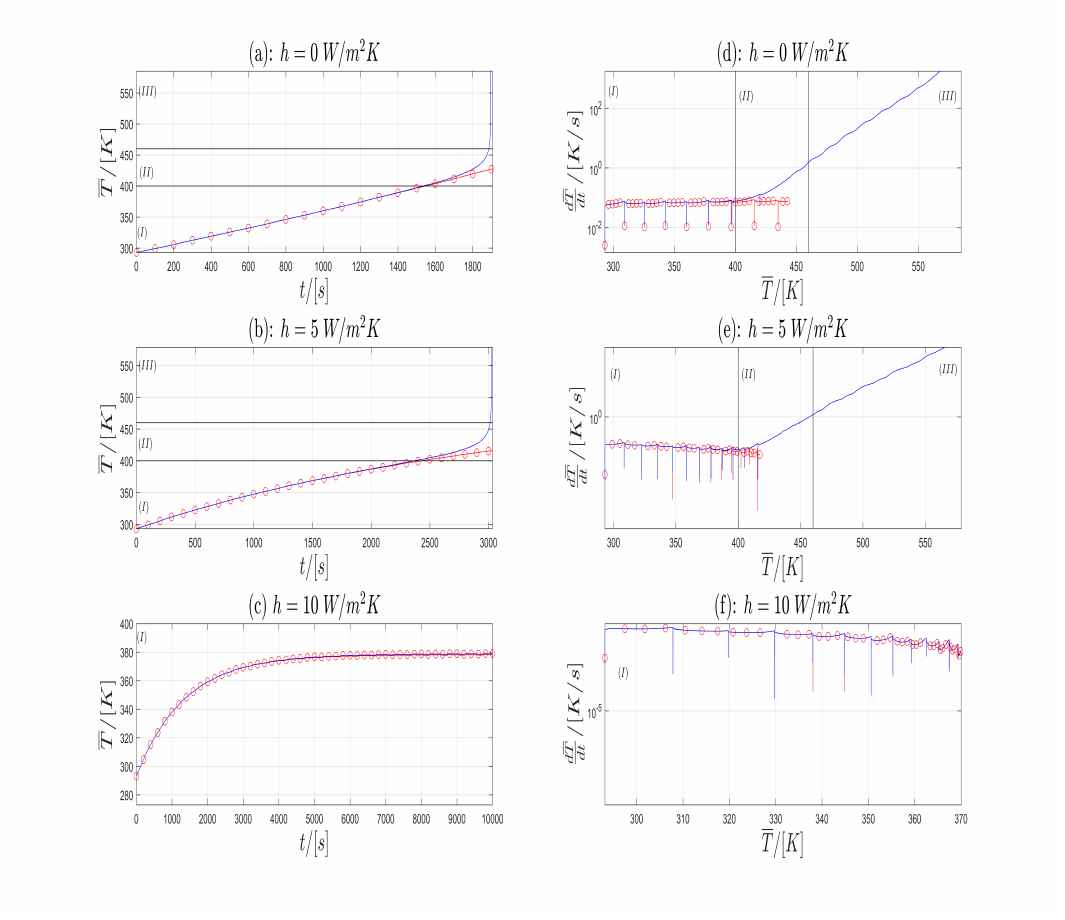
Figure 4. t − T -plot ( a – c ) and corresponding T − d T /d t plot ( d – f ) for the Model A (blue) and Model B (red) and three different h